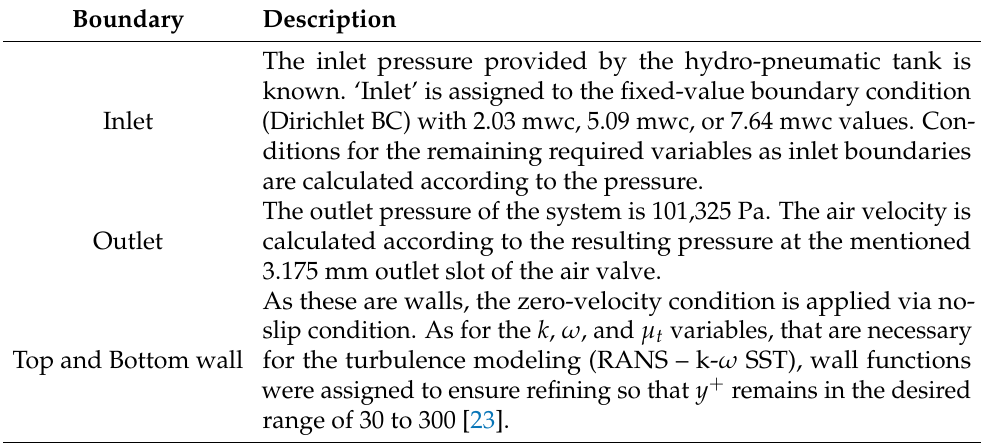
Table 2. Boundary conditions.